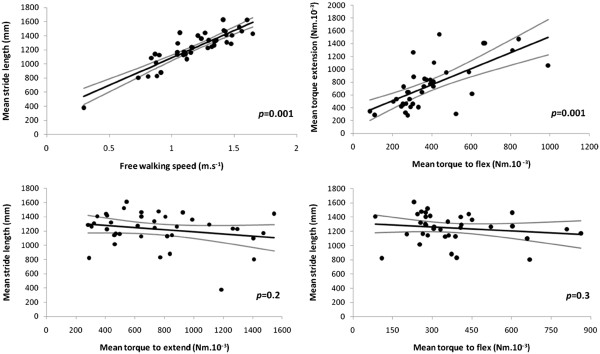
Relationship, in core group, of hypokinesia (stride-length) to bradykinesia (speed) and flexor-rigidity to extensor, and independence of hypokinesia from rigidity. No adjustment is made for demographic covariates. Regression line and 95% CI are shown for stride on speed (upper left graph - point with co-ordinates of stride 378 mm & speed 0.3 m.s-1 not influential); flexor-rigidity on extensor (upper right); stride on flexor-rigidity (lower left); stride on extensor-rigidity (lower right - after removal of an influential point: co-ordinates stride 378 mm & rigidity 990 Nm.10-3).